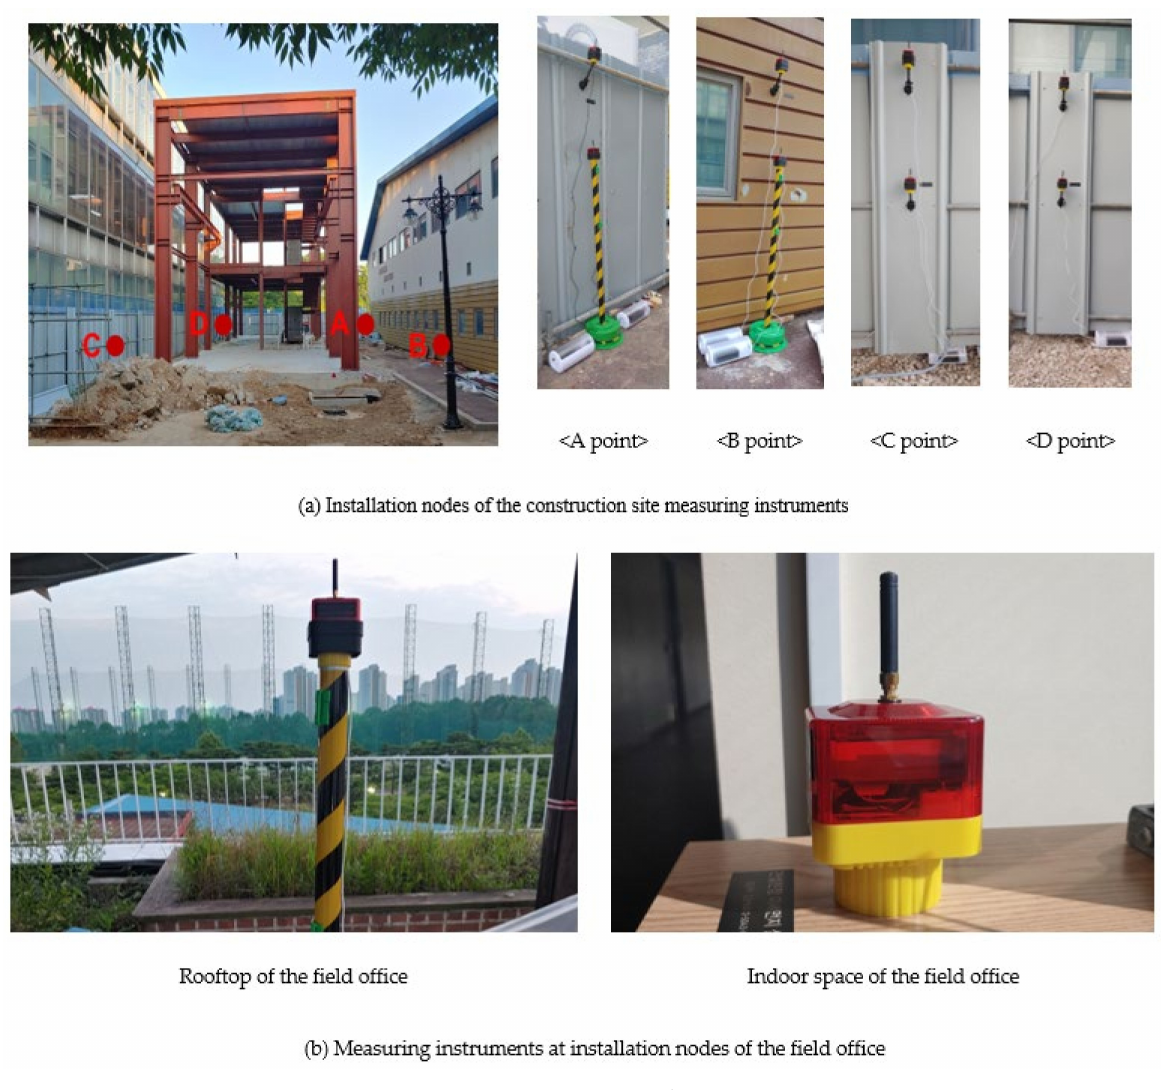
Figure 6. Test site network